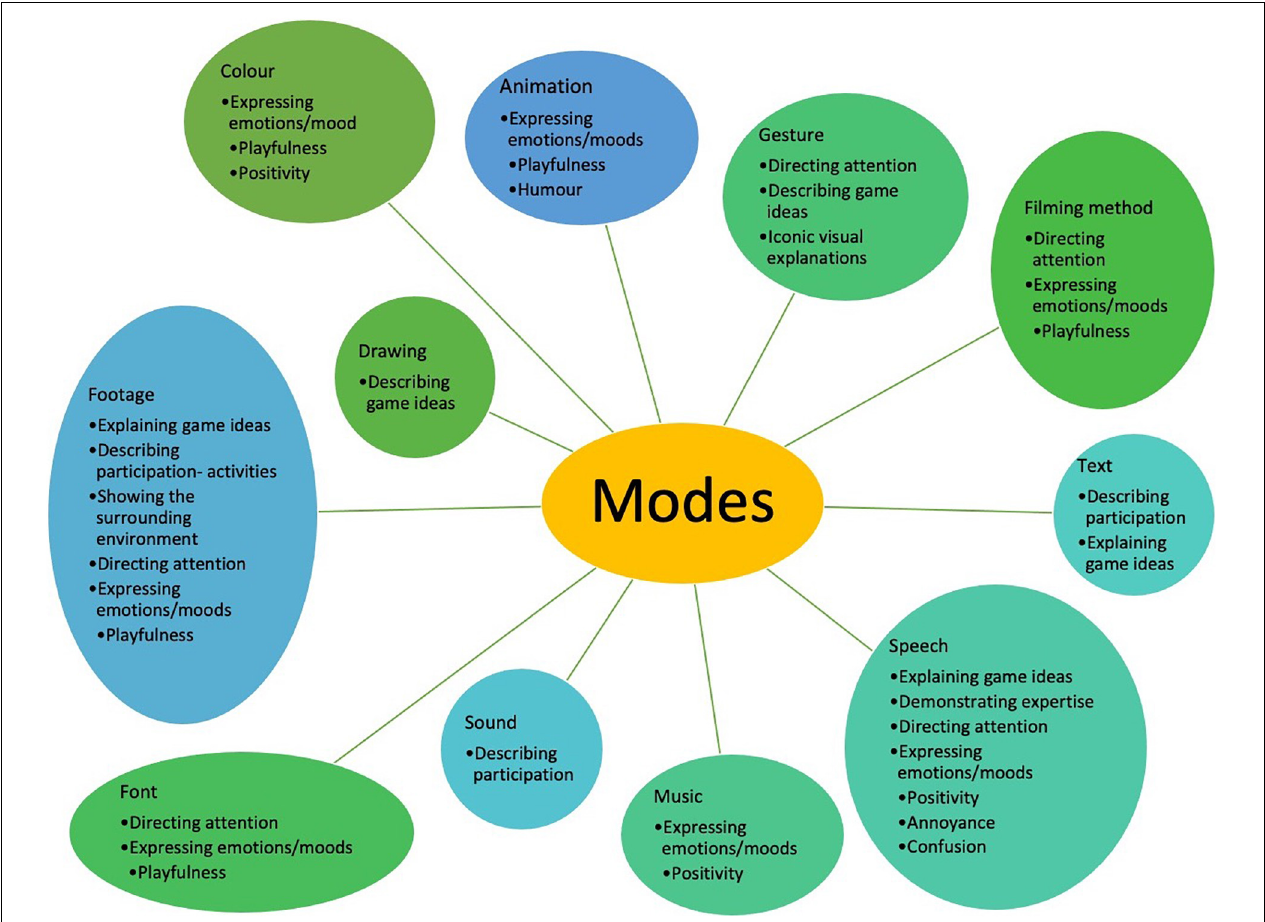
FIGURE 5 | Diagram showing use of individual modes in Jay and Terry’s Digital Story about making their game “Birds with Guns”.